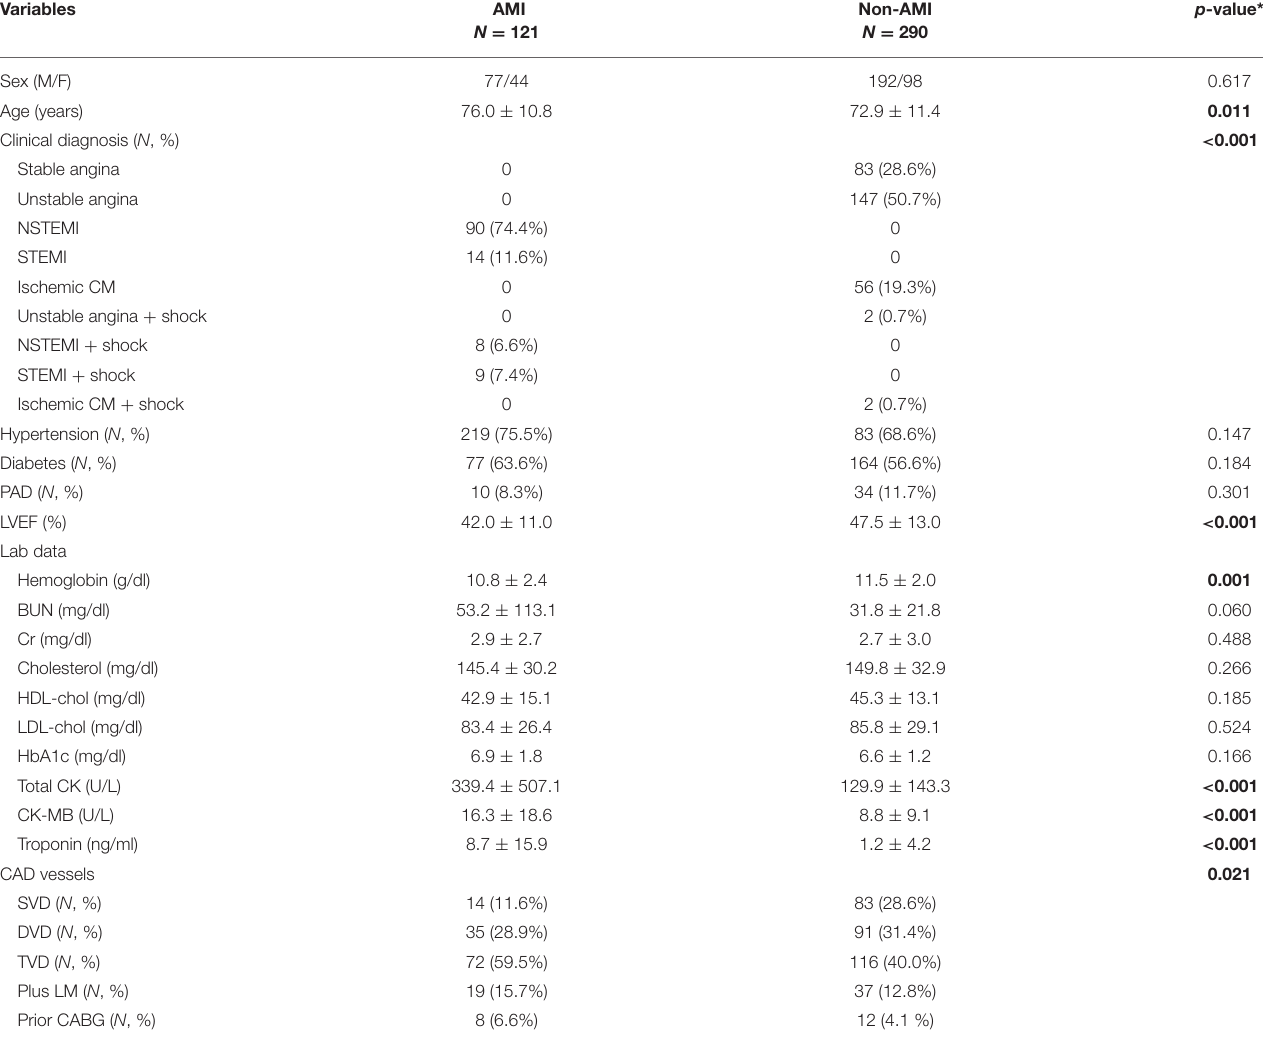
TABLE 1 | Demographic data of rotational atherectomy in acute myocardial infarction (AMI) vs. non-AMI cases in the study period. Variables AMI N =